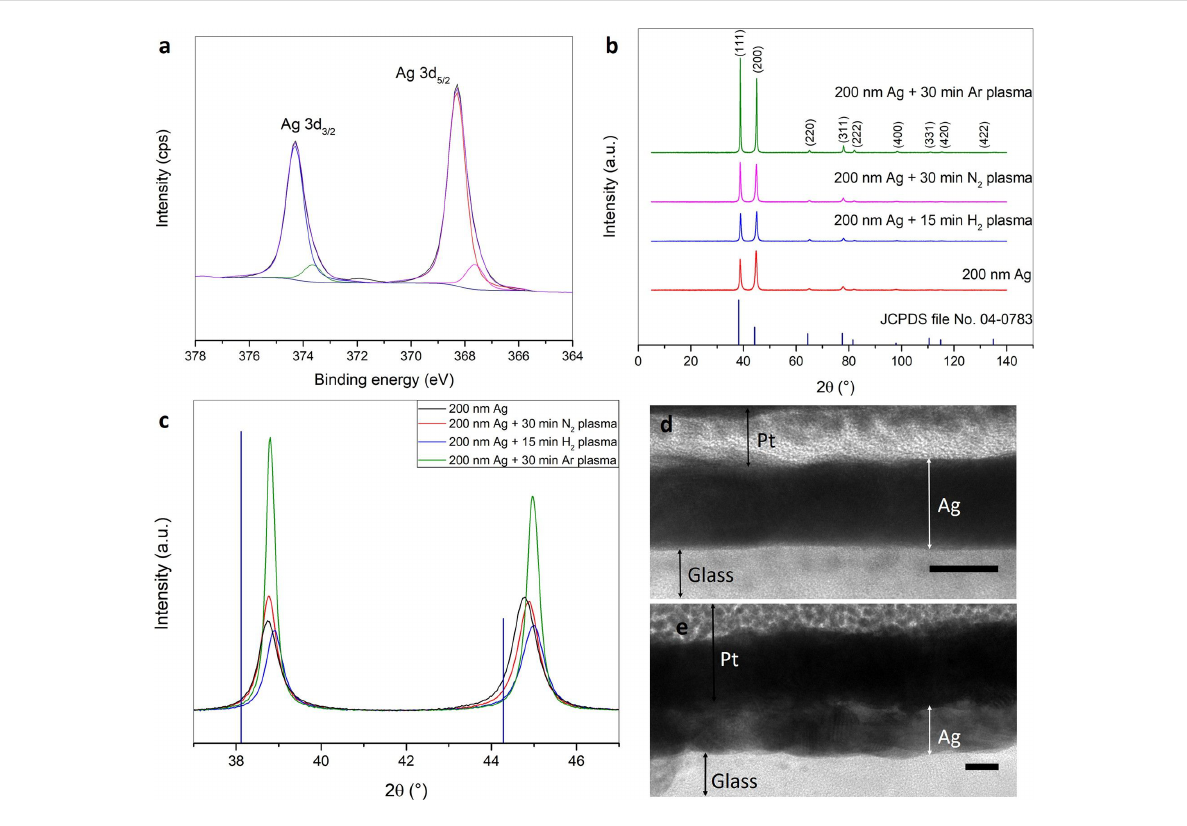
Figure 4: (a) Deconvoluted XPS Ag 3d spectrum for 200 nm Ag + 30 min nitrogen plasma treatment (g12-p200). (b, c) XRD of 200 nm Ag, 200 nm Ag + 15 min hydrogen plasma treatment (g12-p200), 200 nm Ag + 30 min nitrogen plasma treatment (g12-p200), 200 nm Ag + 30 min argon plasma (g16.7-p200) and their comparison with standard XRD pattern for silver as reference (JCPDS file No. 04-0783). Cross-sectional TEM (FIB) images of (d) an as-sputtered 10 nm silver film and (e) 10 nm silver + 5 min nitrogen plasma treatment (g12-p200). Scale bar: 10